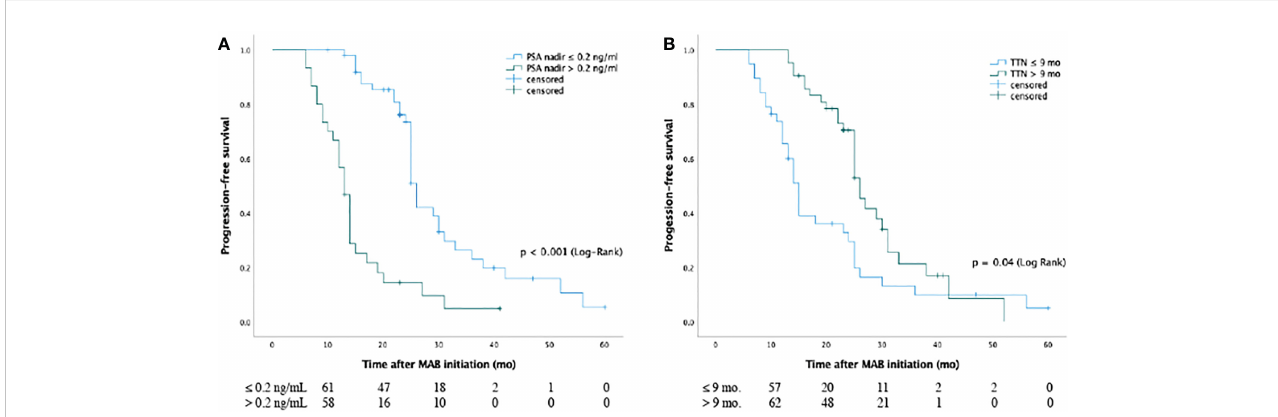
FIGURE 2 Kaplan-Meier curves for biochemical progression-free survival of nPSA (A) and TTN (B) for patients with prostate cancer from MAB initiation. The median bPFS values (A) were 27.6 months and 13.5 months for patients in the two groups with PSA nadir < 0.2 ng/ml and ≥ 0.2 ng/ml, respectively, and there was signi fi cant difference between groups (P < 0.001 [log-rank]). The median bPFS values (B) were 27.8 months and 13.5 months for cases in two groups with TTN ≥ 9 months and < 9 months, respectively, and there was signi fi cant difference between the two groups (P < 0.001 [log rank]). Abbreviations: PSA: Prostate-speci fi c antigen; TTN: time to PSA nadir; MAB: maximal androgen blockade; nPSA: PSA